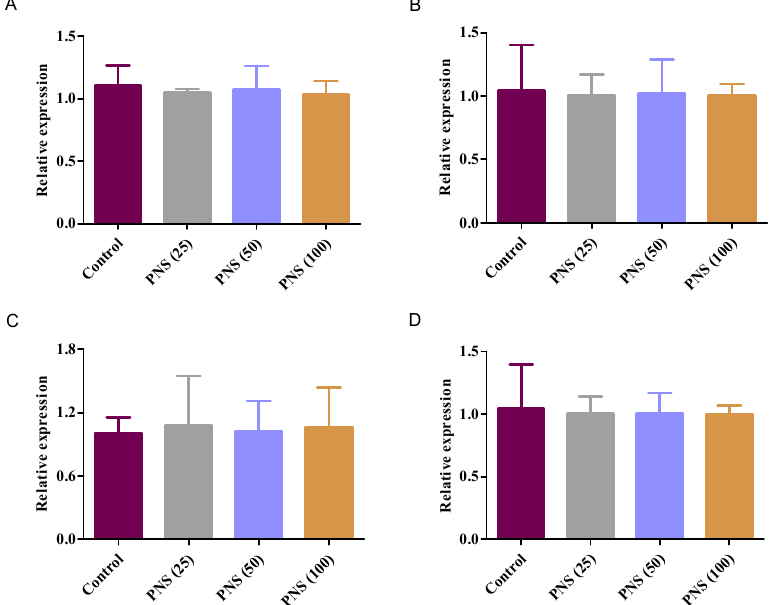
Figure 9. Effects on mRNA expression of human carboxylesterase 1 (hCE1) ( A ), hCE2 ( B ), BChE ( C ), and PON1 ( D ) with PNS treatment. Cells were incubated with PNS for up to 24 h. After the removal of PNS, total mRNA was prepared for qRT-PCR. Data were presented as mean ± SD ( n = 3).